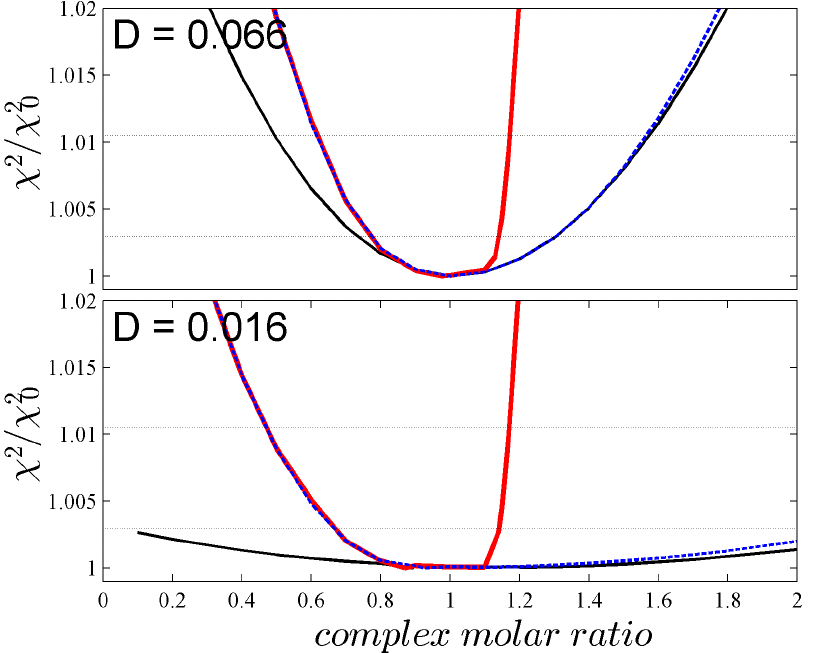
Figure 2. Analogous error surface projections as shown in Fig. 1, but for a more challenging simulated system (System 2) with very dissimilar protein sizes and extinctions (see Results and Figure S2). The data analyses were conducted as described in the legend for Fig. 1, with Tikhonov-Phillips regularization at a level of 0.68. Plotted is again the quality of fit of two data sets with D norm of 0.066 (Top) and 0.016 (Bottom), quantified as ratio of x 2 obtained and the best-fit x 2 0 , as a function of the molar ratio of the high- s segment. Shown are the error surface projections from a standard MSSV analysis (black solid line), the MC-MSSV analysis (blue dotted line), and the MC-MSSV additionally constrained by the absence of component B from the low- s segment (solid red line). For orientation, the x 2 / x 2 0 levels corresponding to P -values of one or two standard deviations by F -statistics are indicated by thin dotted horizontal lines.